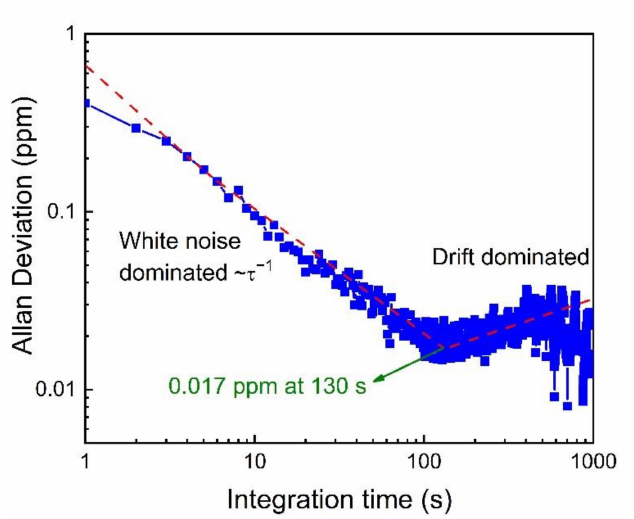
Figure 8. Allan deviation analysis for the HCl-QEPTS sensor. The minimum in the Allan deviation is determined by using the fitting of ~ τ − 1 function for the experimental